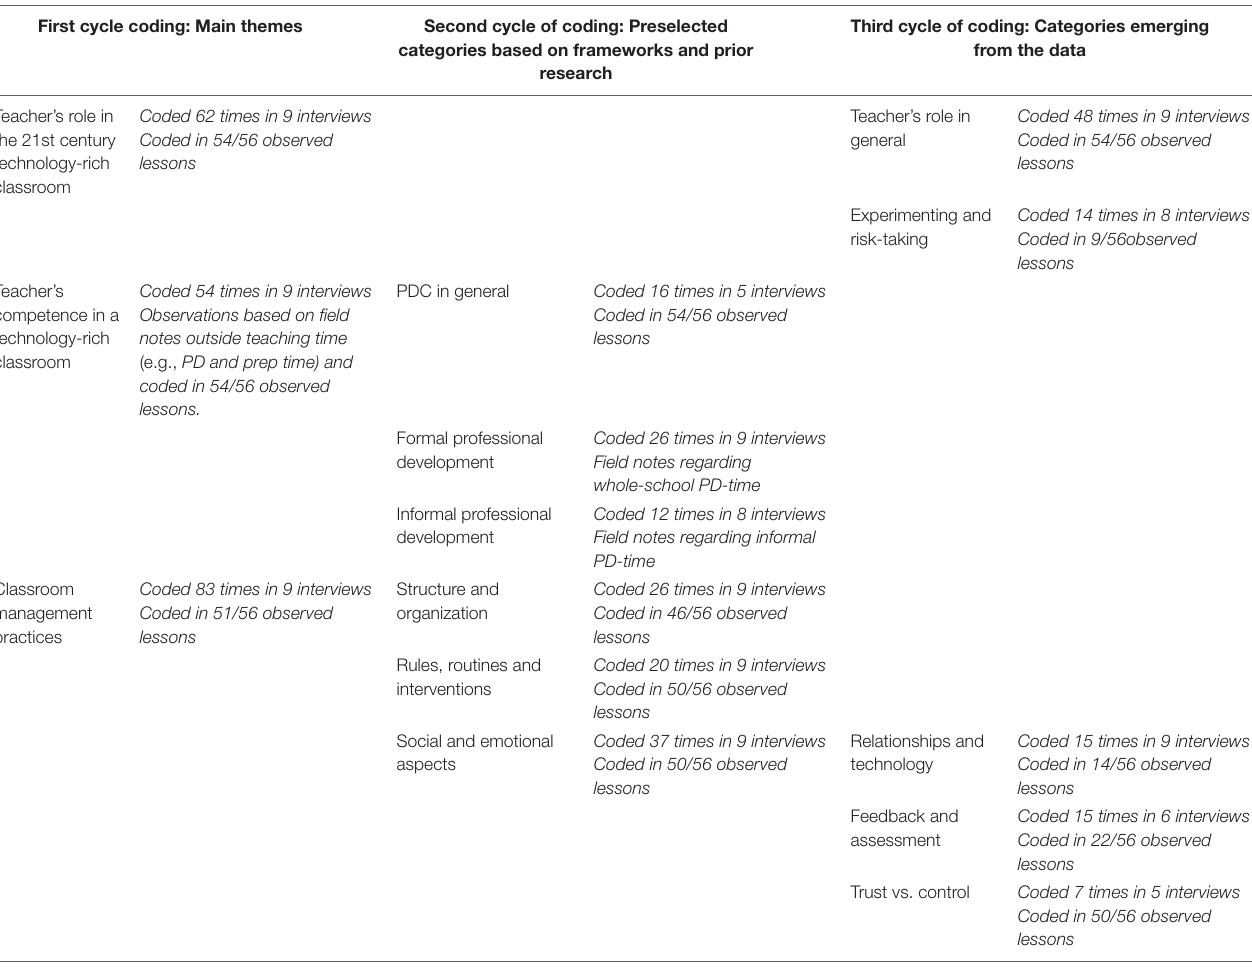
TABLE 1 | Overview of coding of the interviews and observations. First cycle coding: Main themes Second cycle of coding: Preselected